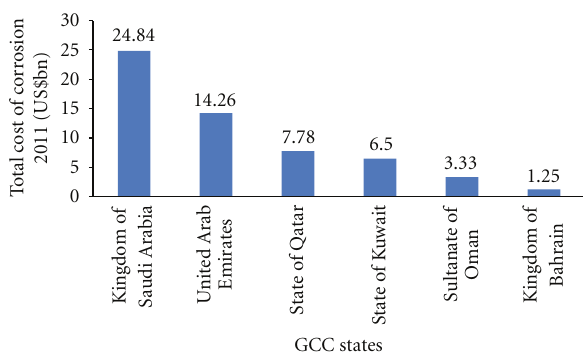
Figure 1: Annual cost of corrosion for GCC states (US$ bn), 2011 estimate